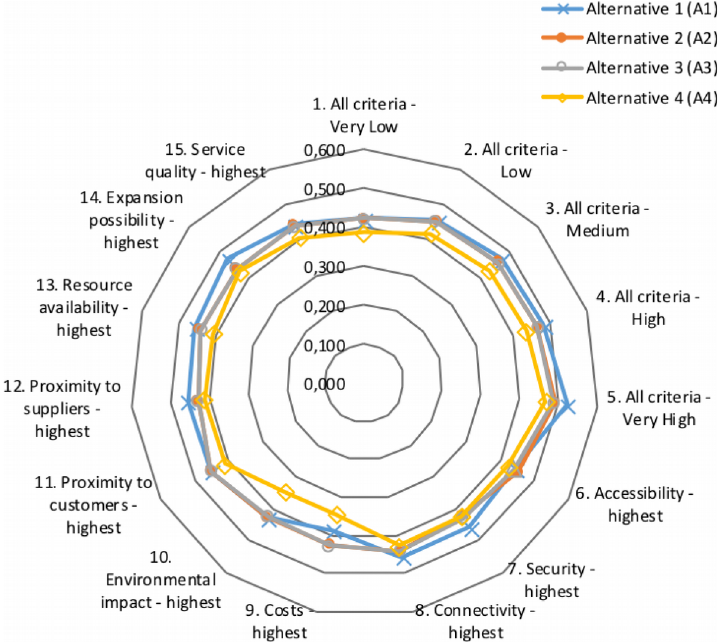
Figure 3. Sensitivity analysis